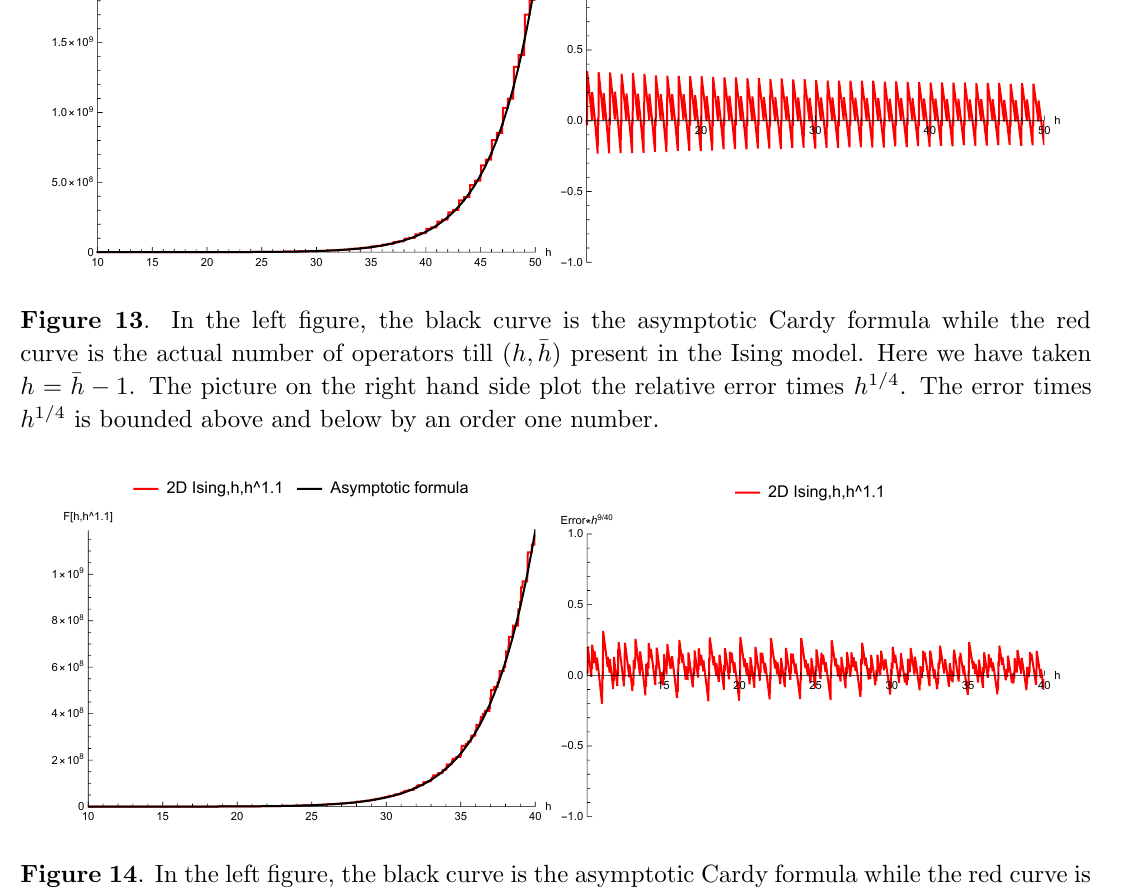
Figure 14 . In the left (cid:12)gure, the black curve is the asymptotic Cardy formula while the red curve is the actual number of operators till ( h; (cid:22) h ) present in the Ising model. Here we have taken h 1 : 1 = (cid:22) h . The picture on the right hand side plot the relative error times h 9 = 40 . The error times h 9 = 40 is bounded above and below by an order one